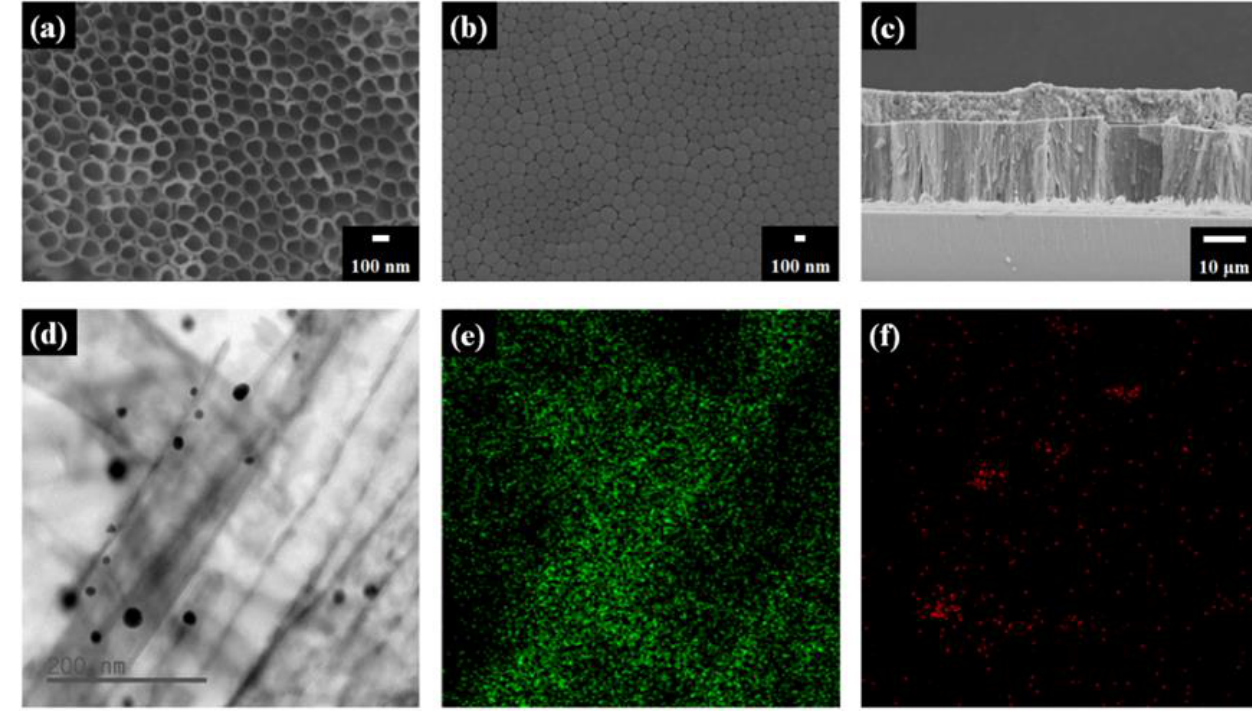
Figure 2. Field-emission scanning electron microscopy (FE-SEM) images of ( a ) top view of f-TNTAs, ( b ) bottom view of f-TNTAs, ( c ) side view of scattering layer and f-TNTAs by FE-SEM, ( d ) transmission electron microscopy (TEM) image of f-TNTAs with Au NPs, ( e ) element mapping of Ti (green) from TiO 2 , and ( f ) element mapping of Au (red) from Au NPs.